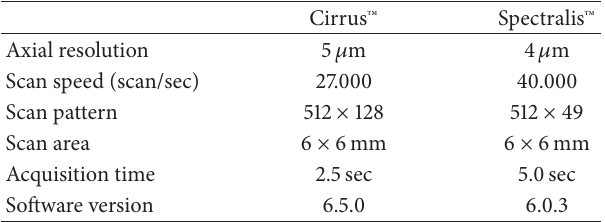
Table 1: Technical characteristics from Cirrus and Spectralis OCT and acquisition protocol details of each